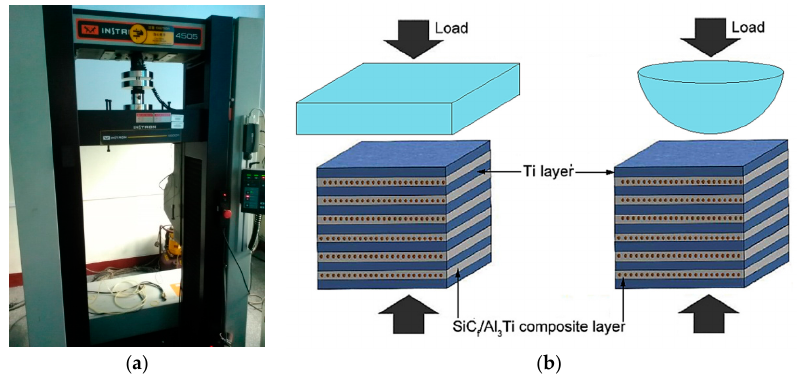
Figure 6. ( a ) Instron 5500R load frame device, ( b ) Specimen configurations employed in compressive tests.